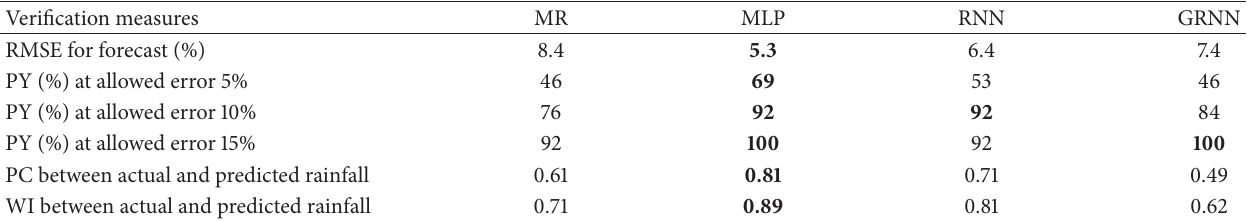
Table 9: Prediction evaluation statistics for ensemble models during test period 2001–2013 (Section 4.5).